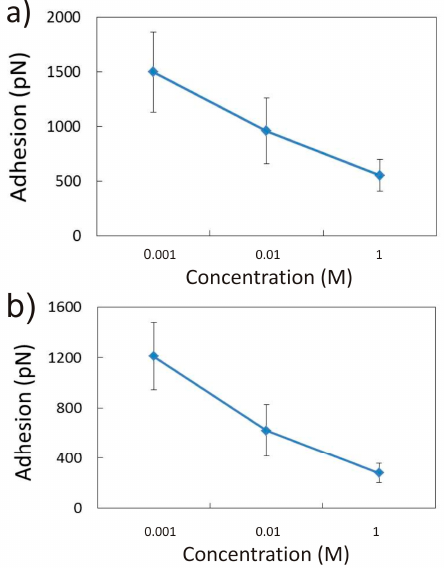
Figure 8. Effect of CaCl 2 concentration on the measured adhesion of –COOH groups over the aluminol face of two different kaolinite crystals, ( a ) and ( b ) (kao-Al-1). face of two different kaolinite crystals from experiment Ka-Al-1. ( a ) the effect on crystal A; ( b ) the effect on crystal